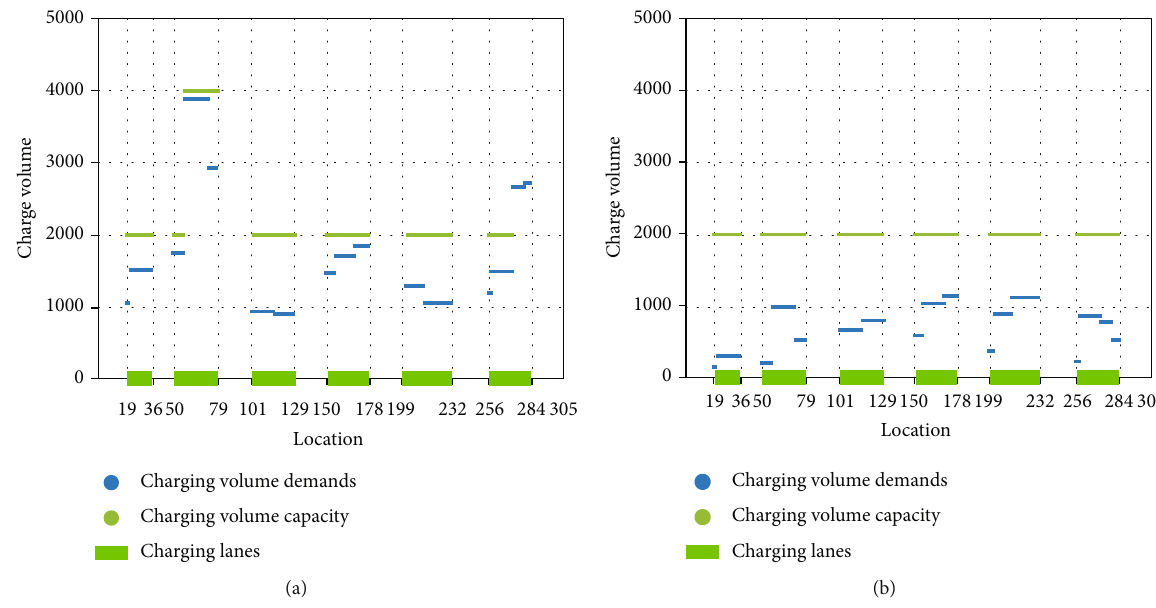
Figure 10: DWC lane deployment comparison (a) before and (b)